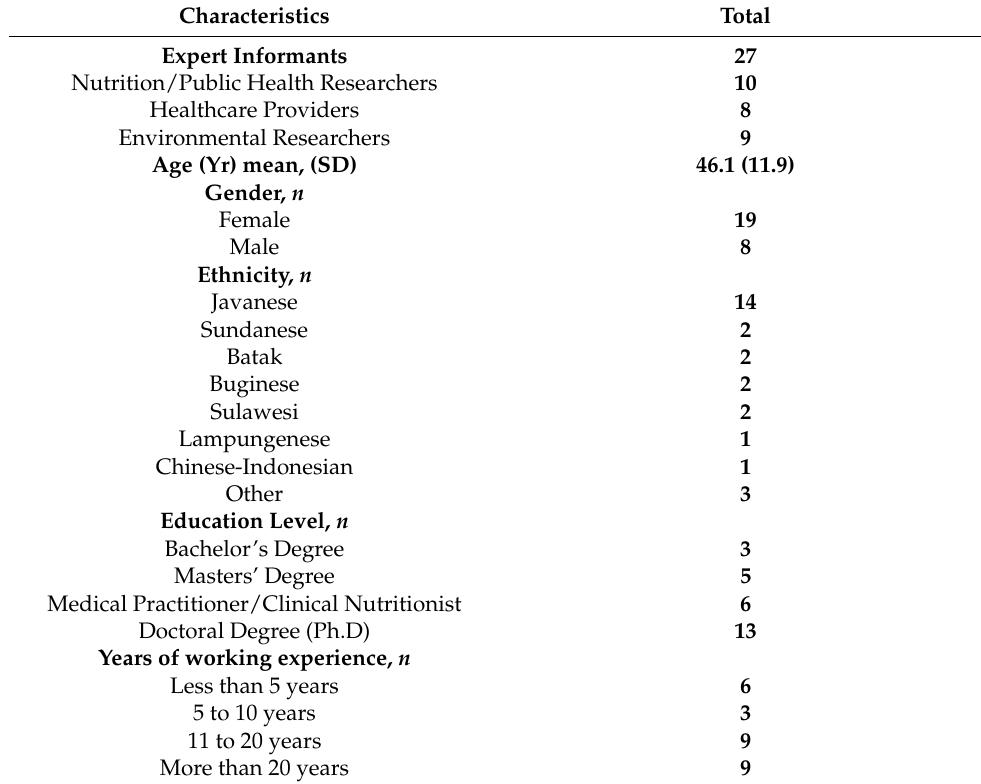
Table 1. Demographic Characteristics of Expert